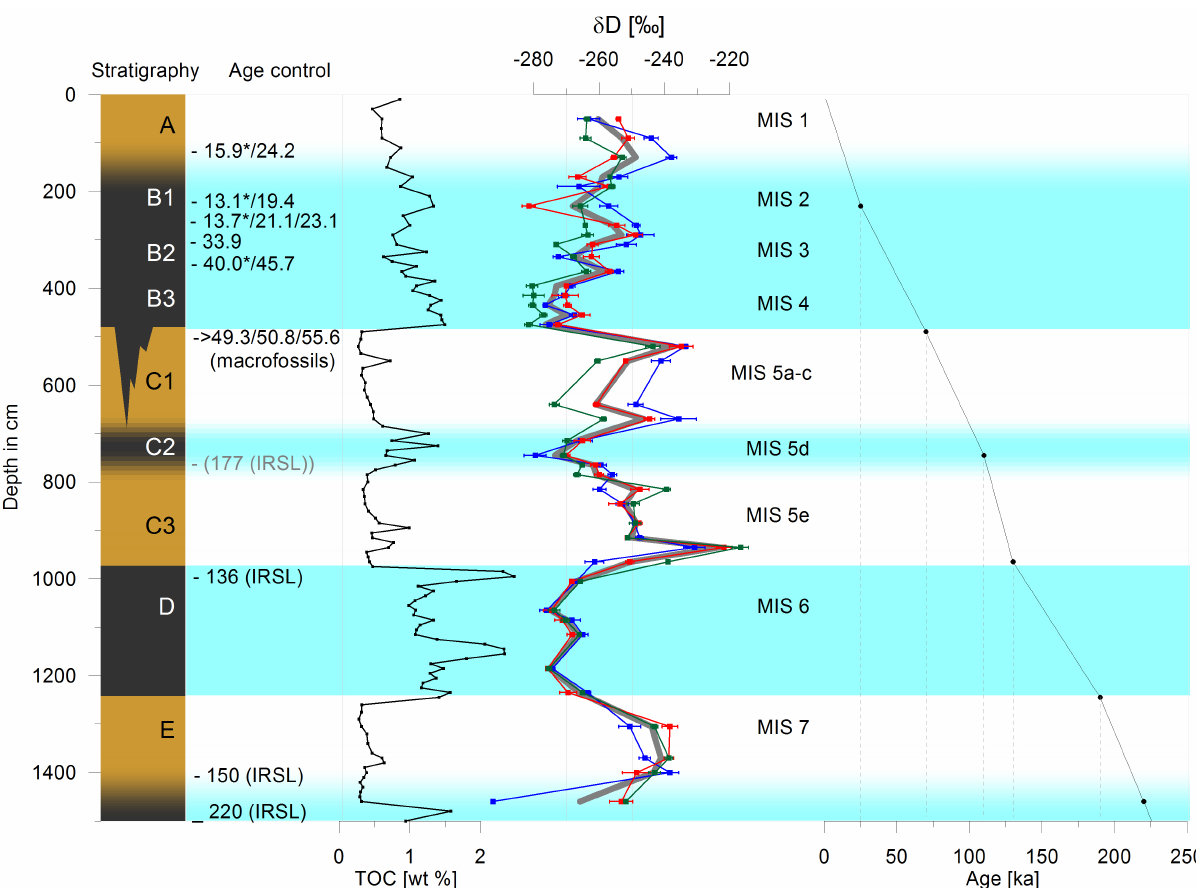
Fig. 2. Stratigraphy and analytical results for the Tumara Paleosol Sequence. The stratigraphy illustrates the distinction between organic-rich, dark grey units (B and D) and bright brown organic-poor units (A, C and E). Calibrated radiocarbon ages (cal. ka BP) have been obtained for the upper part of the profile (* humic acids, others: humins, macrofossils from within the ice wedge), and infrared stimulated luminescence ages (IRSL) for the lower part (Zech et al., 2010a). TOC is the total organic carbon concentration, and δ D shows the deuterium/hydrogen isotope ratios measured on the n-alkanes C27, C29 and C31 (in blue, red and green, error bars show standard deviation of triplicate measure- ments, grey line is the average of all three alkanes). The correlation with marine isotope stages (MIS) and the age-depth model are shown to the